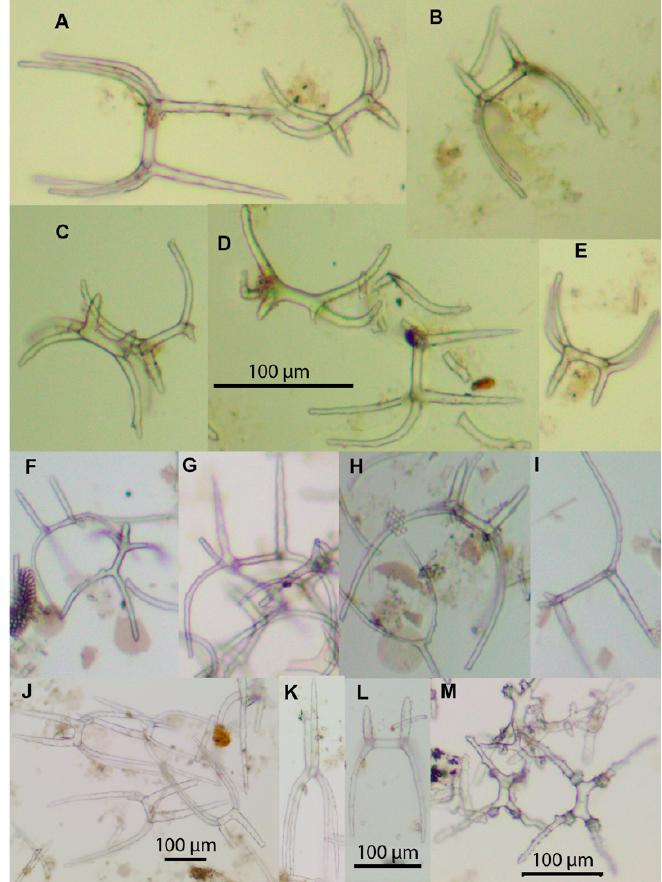
Figure 1. Peniagone dubia and P. minuta sp. nov. ( A , B ) P. dubia , dorsal and ventral view of specimen IORAS ECH01476; ( C – L ) P. minuta : ( C , D ) dorsal and ventral view of the holotype, dorsal ( E – L ) and ventral ( M , N ) ossicles, scale 0.2 mm, a pair of arms and apophyses omitted on ( I , K , N ).